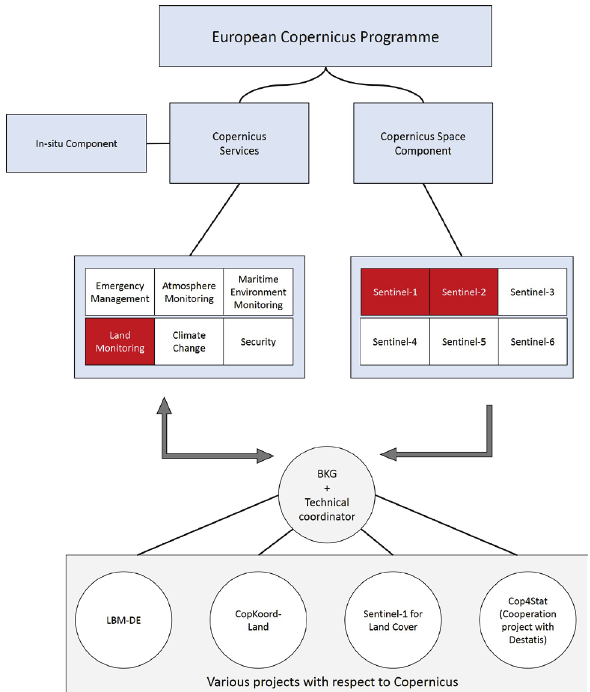
Figure 1: Simplified overview of the Copernicus programme (http://www.copernicus.eu/) showing the interaction and the current efforts at the